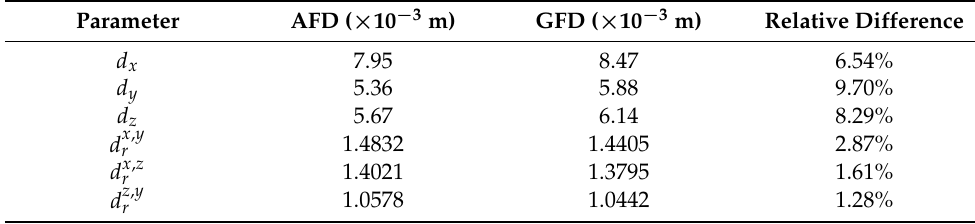
Table 2. Feret diameters and relative Feret diameters of the AFD and GFD. Parameter